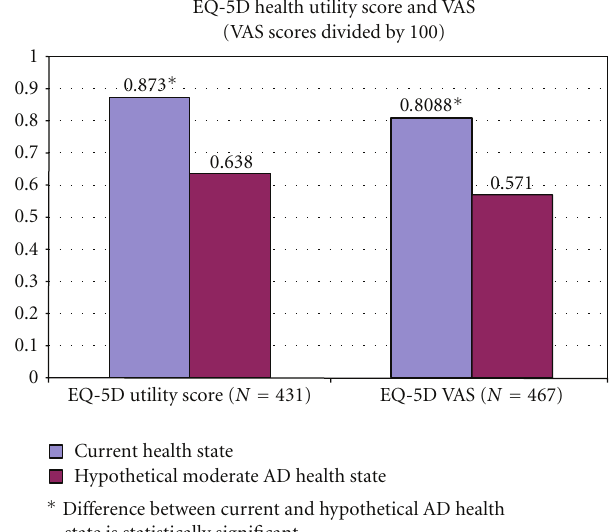
Figure 2: Current health state versus hypothetical moderate AD state (weighted